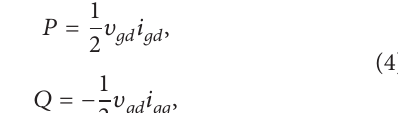
Figure 6: Power calculation based on Discrete Fourier Transform